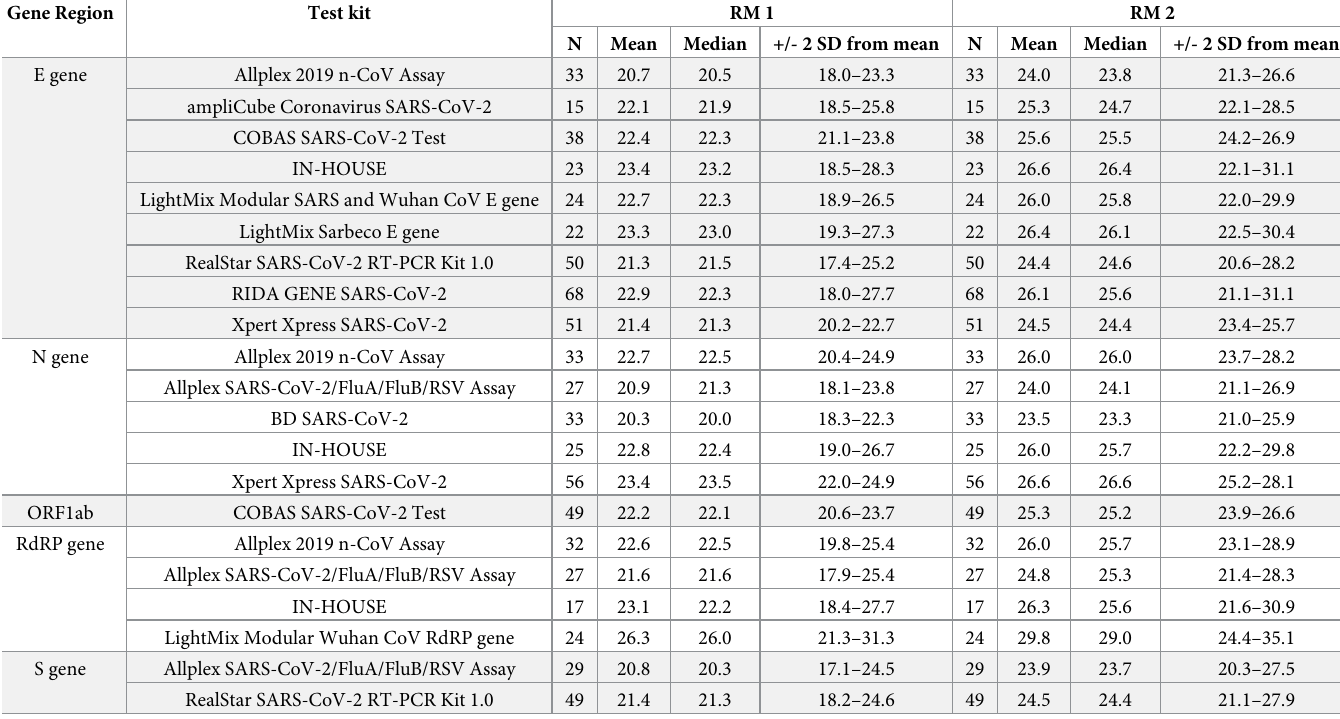
Table 3. Statistical analysis of Ct value distribution per gene region and test system for RM 1 and RM 2. Additional information can be found in S3